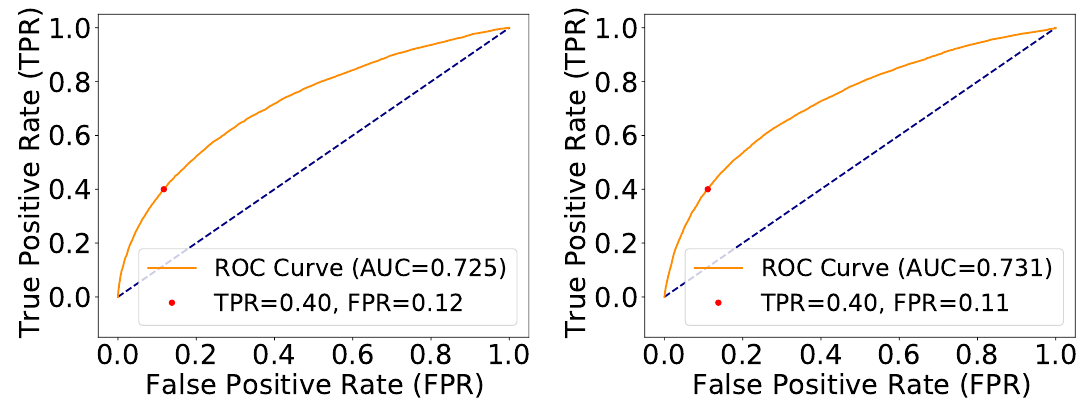
Figure 7 . Comparson between ROC curves of the unweighted training scheme (left) and the weighted training scheme